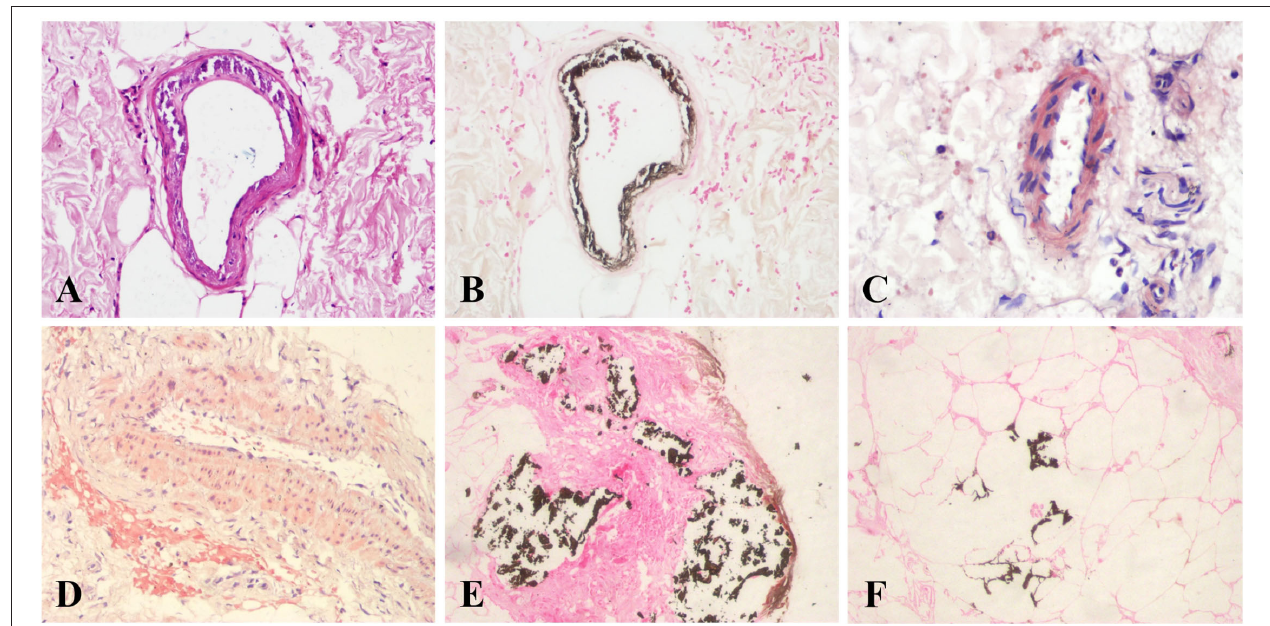
FIGURE 2 | Histopathological features of calciphylaxis. Calciphylaxis skin biopsy specimens show calcification of subcutaneous arteriole media with extensive calcium deposition in extravascular interstitial tissue and fibrous septum of adipose tissue. (A) H&E staining, (B,E,F) von Kossa staining, and (C,D) Alizarin red S staining. Original magnification ×